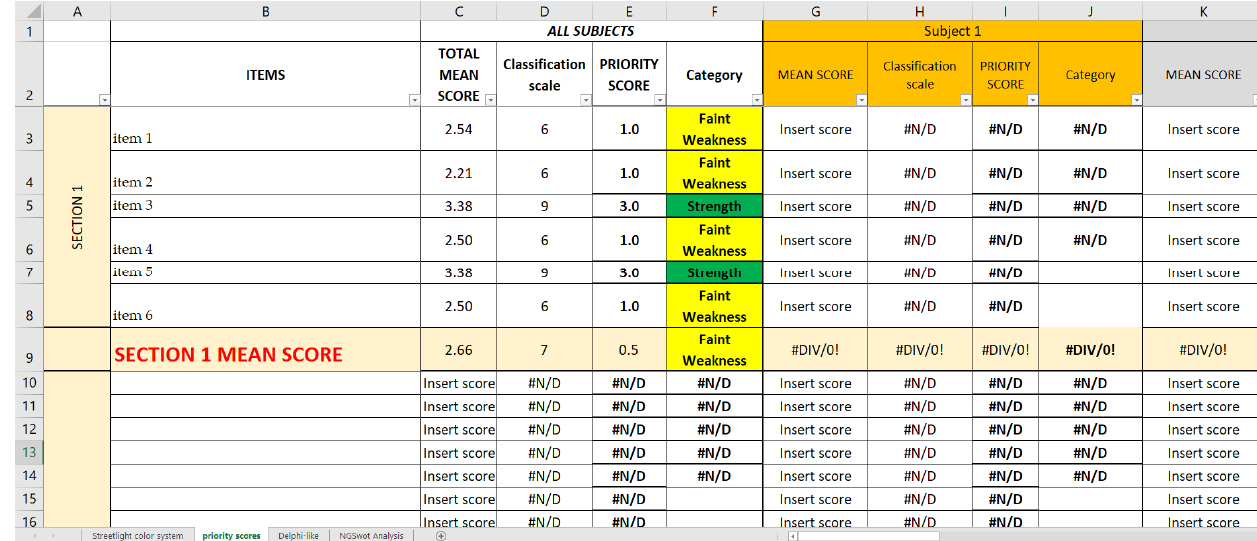
Figure 4. Example of Priority scores sheet of SPRIS; for each mean score, we report the correspondent